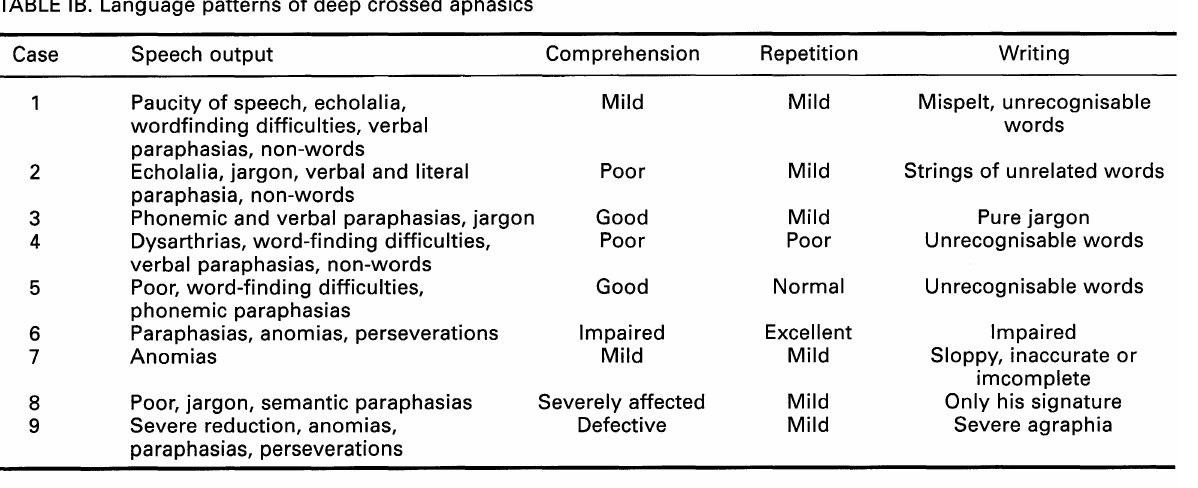
TABLE lB. Language patterns of deep crossed